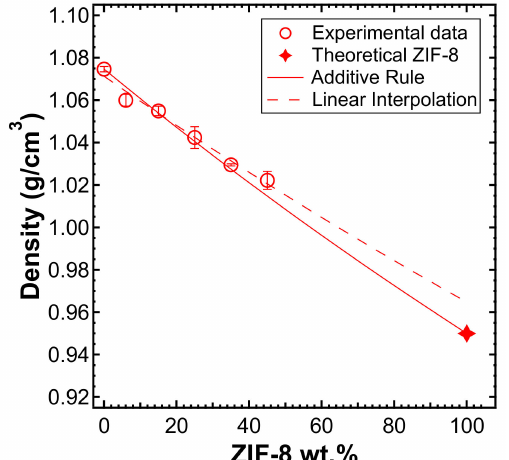
Figure 4. Density of the mixed-matrix membranes (MMMs) versus ZIF-8 weight fraction in the film (empty circles), measured with the buoyancy technique in water. Solid line represents the additive rule and was evaluated by the experimental density of PPO and the theoretical density of ZIF-8. Dashed line represents the linear interpolation of the experimental values measured, extrapolated to pure